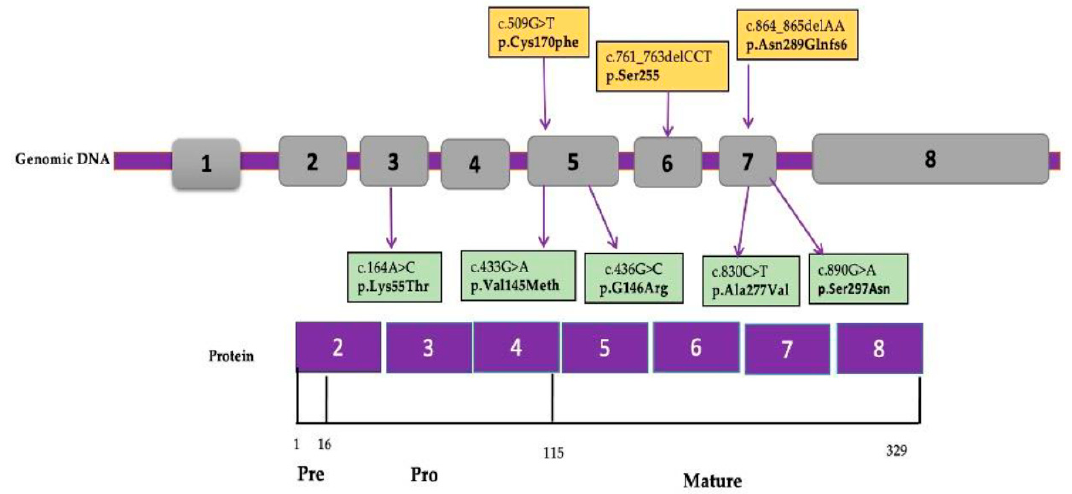
Figure 4. CTSK exons and their corresponding protein domains. CTSK gene has 8 exons encoding 329 amino acids, and numbers refer to amino acid positions. Eight mutations were identified: three novel mutations (yellow boxes) and five previously reported mutations (green boxes).